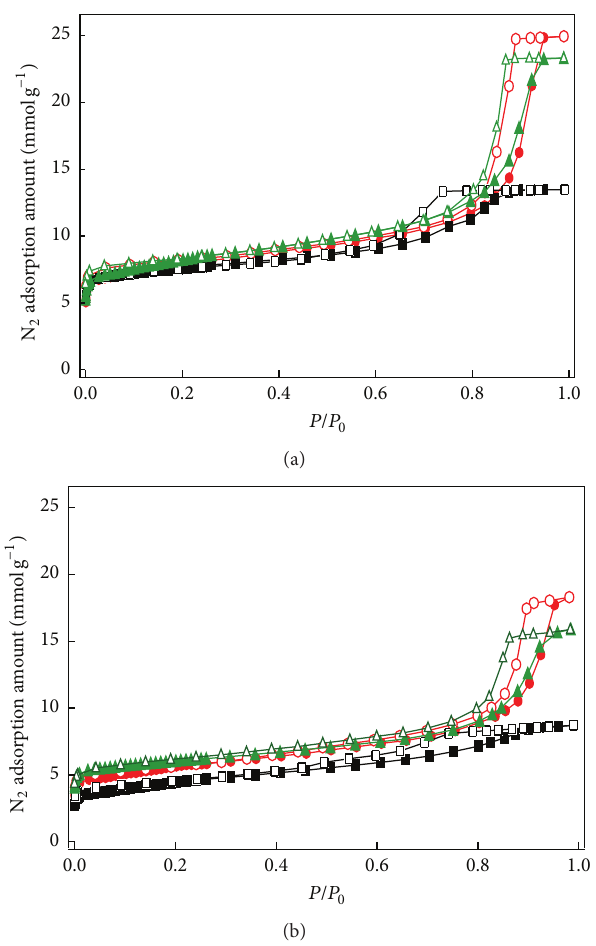
Figure 1: N 2 adsorption isotherms of (a) CAs and (b) x CA–KC samples at 77 K. Pore widths: black, 7nm; green, 16 nm; red, 18 nm.